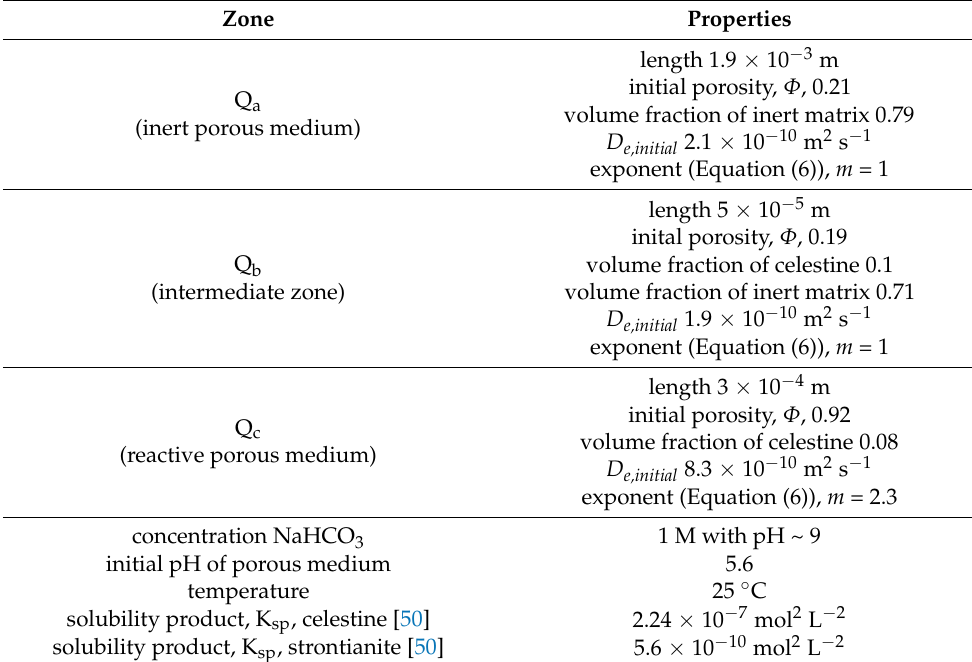
Table 1. Properties of the different zones and composition of the injected solution in the 1D continuum scale reactive transport